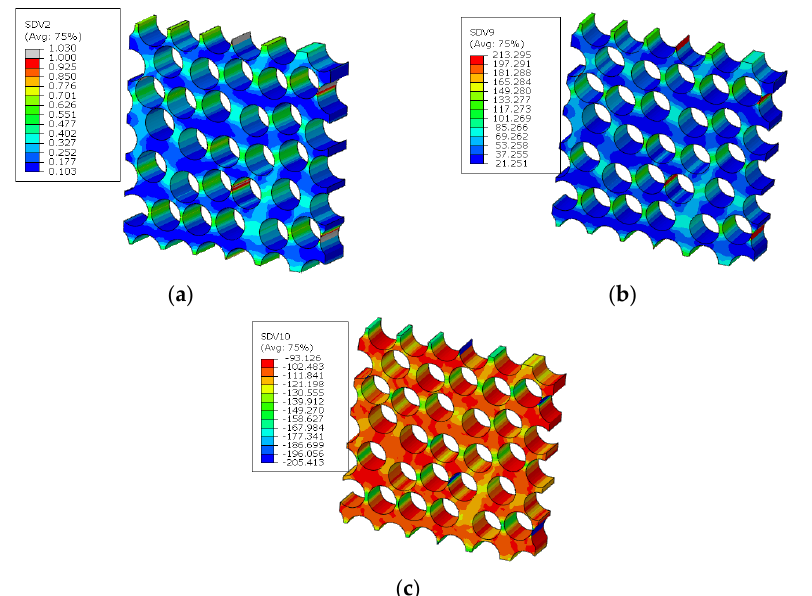
Figure 34. Failure indices and stress states in the matrix of fiber random distribution model. ( a ) failure indices; ( b ) equivalent stress; ( c ) first stress invariant.